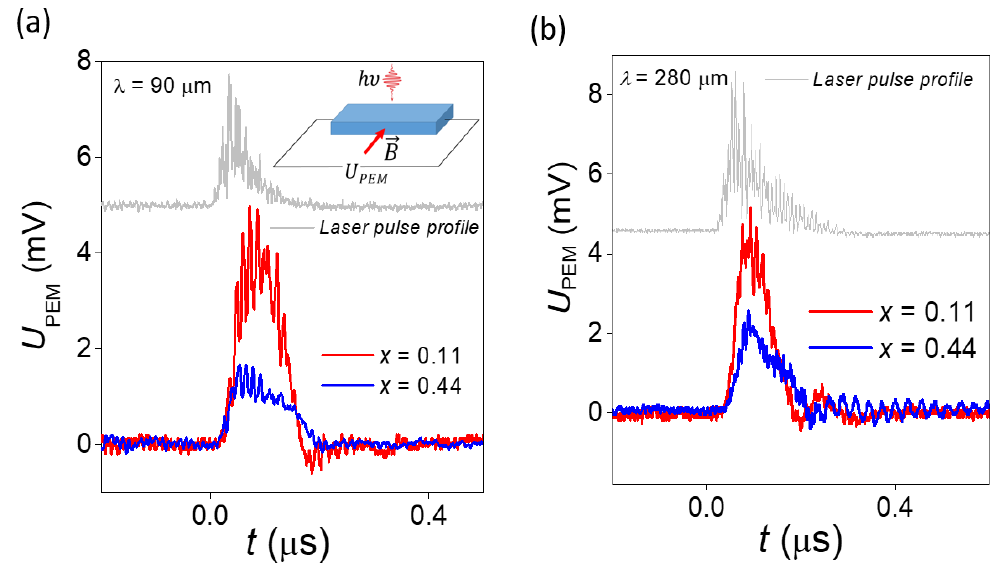
Figure 1. A typical PEM effect voltage kinetics measured in trivial ( x = 0.11) and topological ( x = 0.44) phase samples. Photoexcitation wavelengths λ = 90 μm ( a ) and 280 μm ( b ).